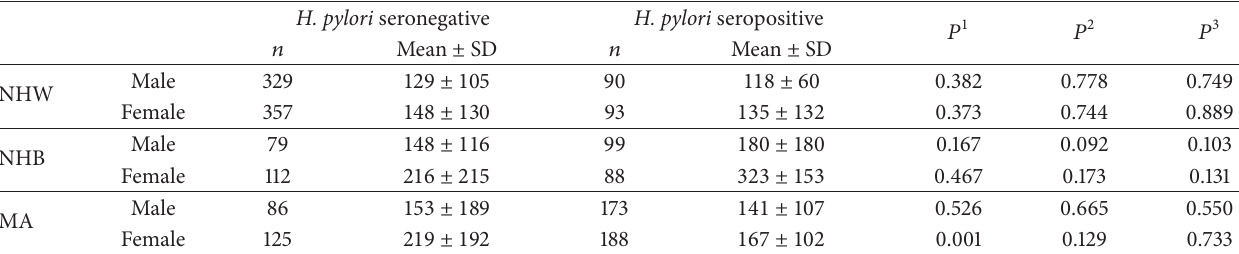
Table 5: Comparison of HOMA-B based on H. pylori